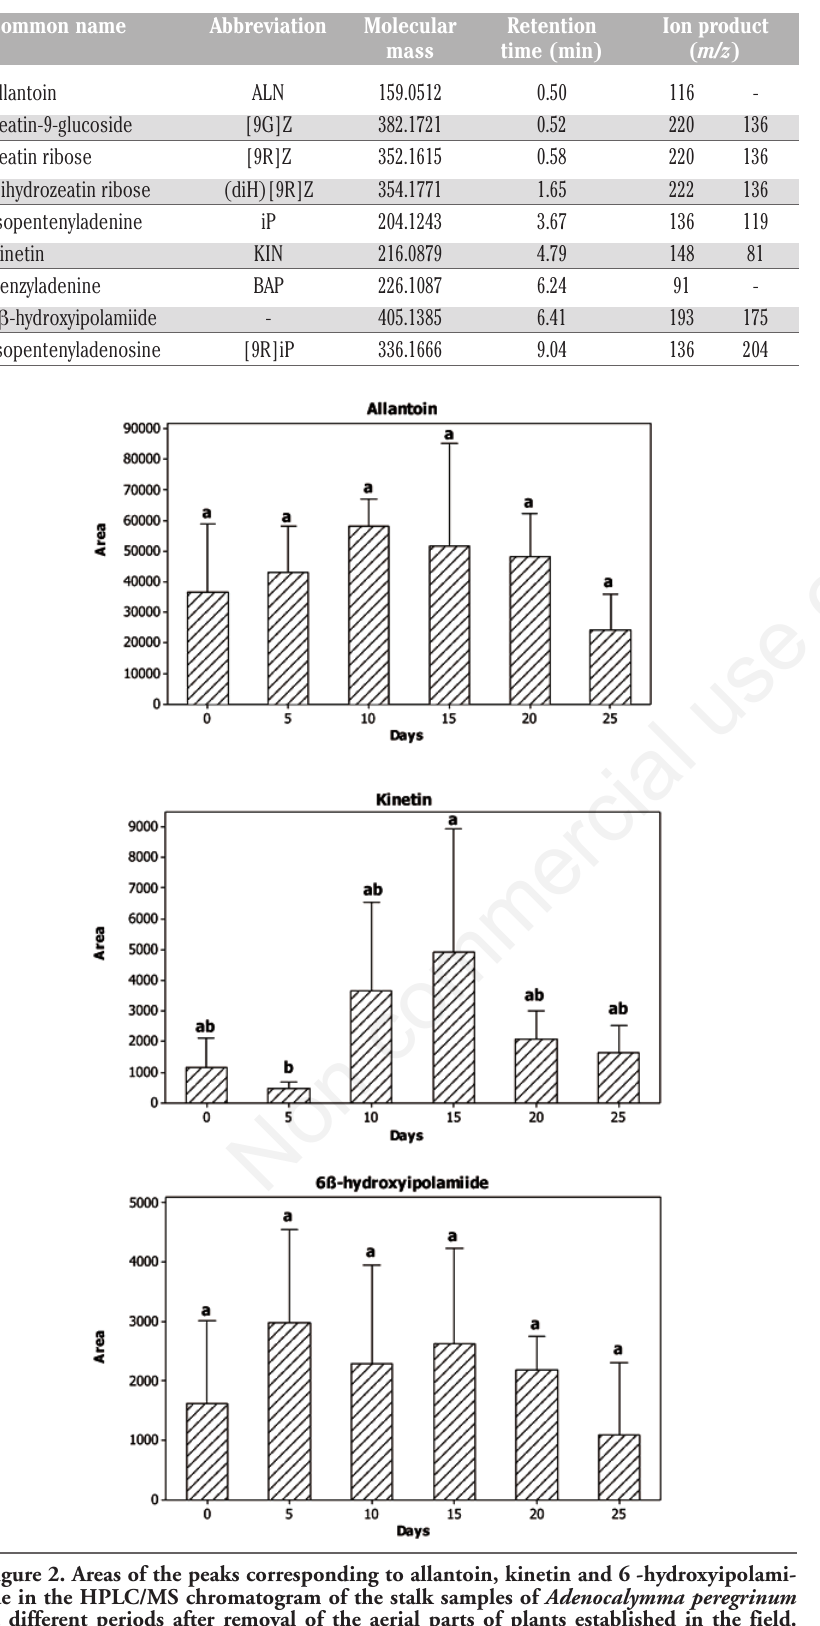
Table 1. Compounds, abbreviations, molecular masses, retention times and compound fragments observed by mass spectrometry.